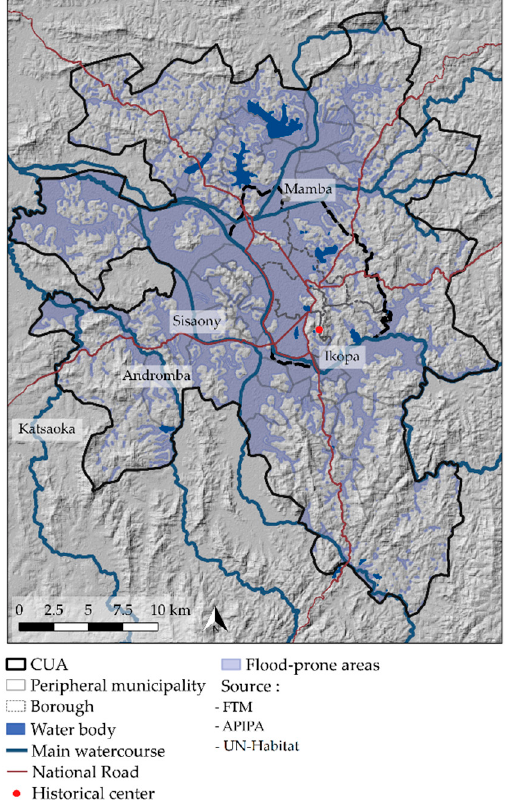
Figure 3. Flood-prone areas.